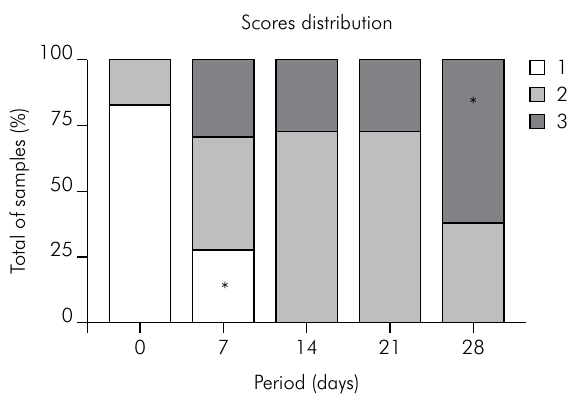
Figure 1. Relative distribution of the samples according to the scoring system in each experimental group (0 = control, 7, 14, 21, and 28 days). *Significant difference compared to the control group ( p < 0.05, Z test comparing two